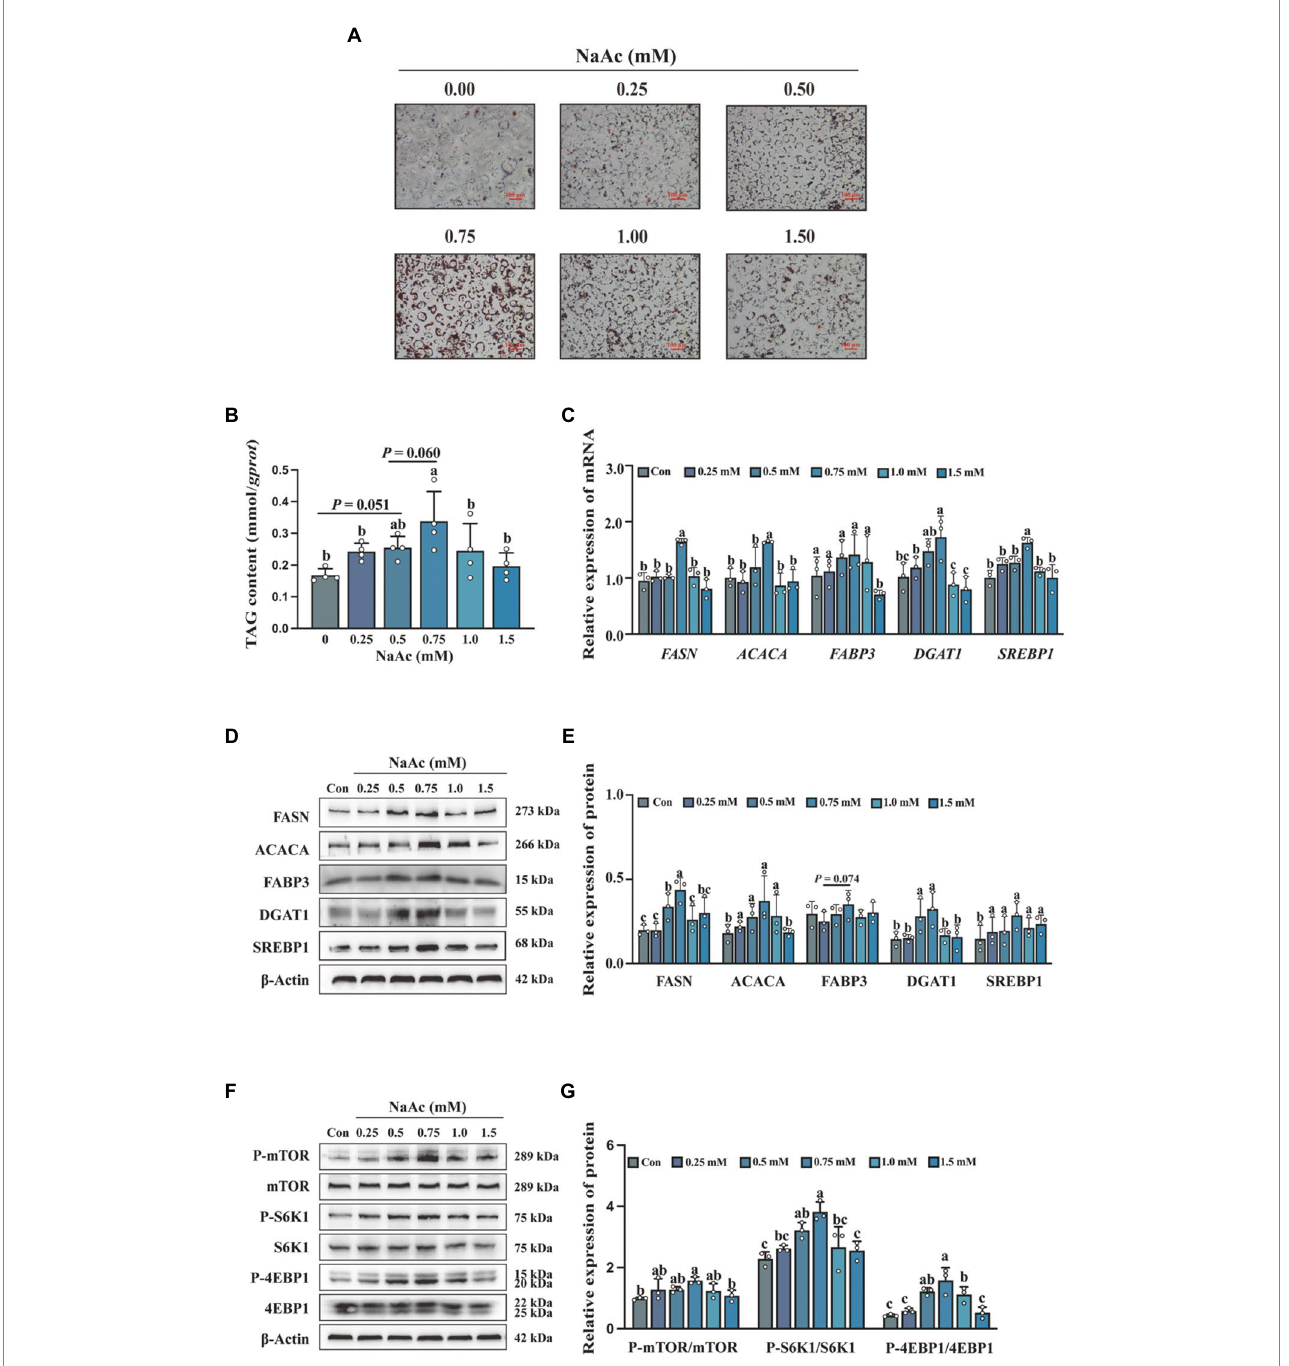
FIGURE 2 Sodium acetate (NaAc) promoted milk fat synthesis and activated the mTORC1 signaling pathway in HC11 cells. HC11 cells were exposed to different concentrations (0.00, 0.25, 0.50, 0.75, 1.00, and 1.50 mM) of NaAc. (A) Oil red O staining images of HC11 cells. Scale bars are 100 μ m. (B) TAG content of HC11 cells. (C) Relative mRNA expression abundance of genes related to milk fat synthesis. (D–G) Relative expression abundance of proteins related to milk fat synthesis and mTORC1 pathway. All data with error bars are averages ± SEM ( n = 3). In histograms, no letter or the same letter above the bar graph indicates no significant difference ( p > 0.05), and different letters indicate a significant difference ( p < 0.05). Each small white dot represents a test